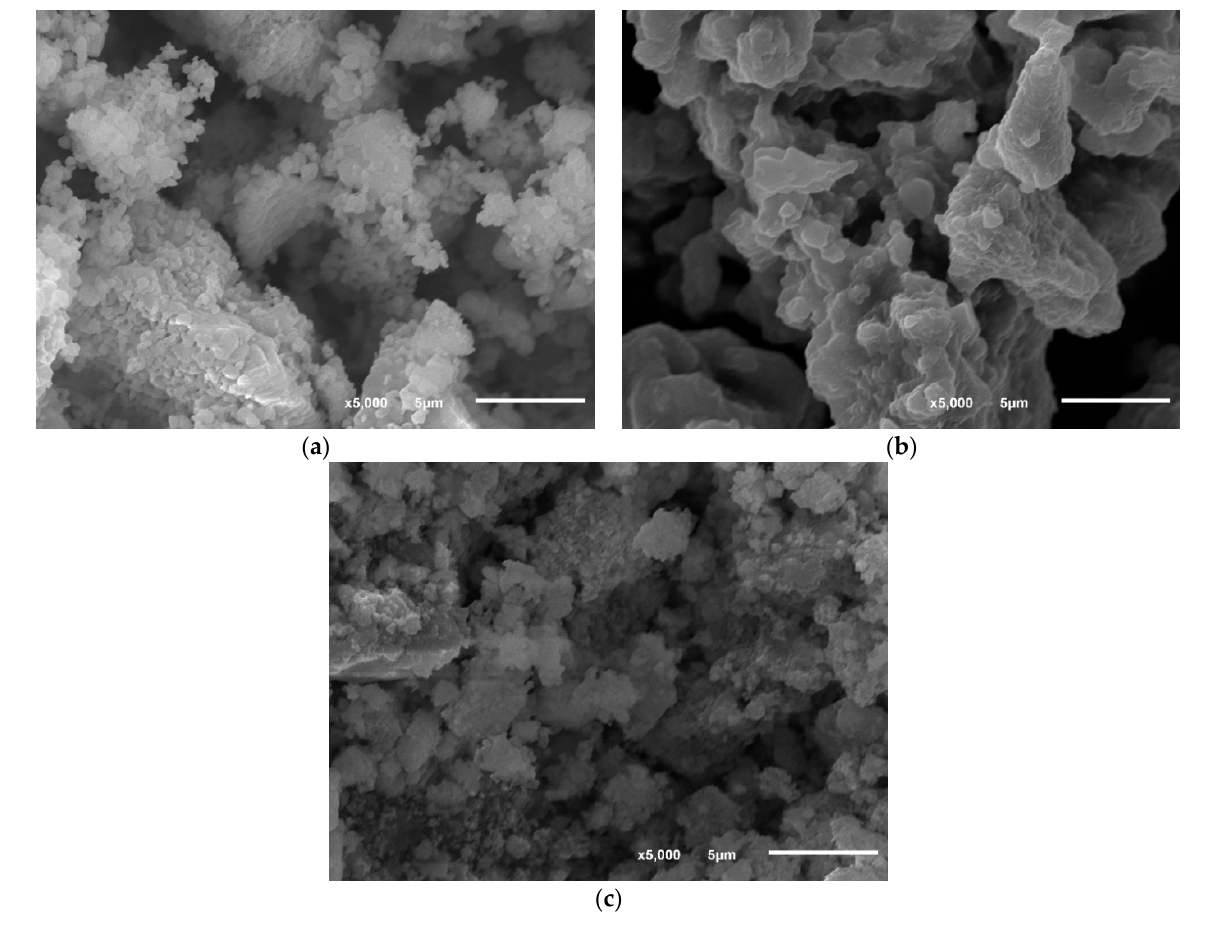
Figure 1. SEM micrographs of Na 1.2 Zr 1.9 Co 0.1 (PO 4 ) 3 ( a ), Na 1.5 Zr 1.75 Co 0.25 (PO 4 ) 3 ( b ), and Na 2 Zr 1.5 Co 0.5 (PO 4 ) 3 ( c ) powders.